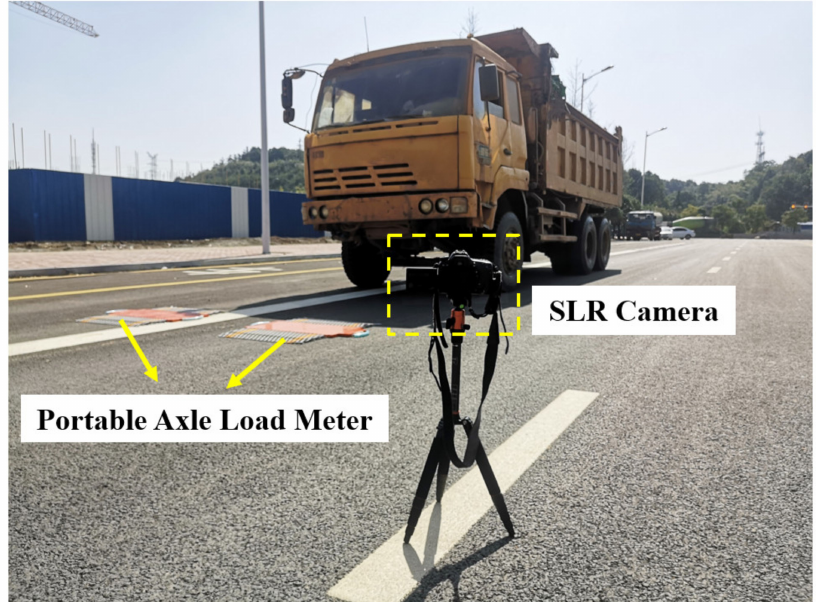
Figure 17. Field experiment.